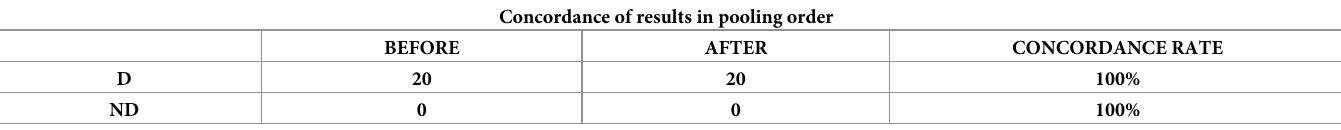
Table 3. Concordance in pooling